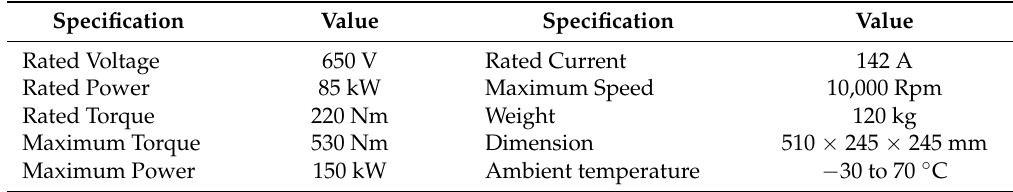
Figure 8. Power and torque characteristics of traction motor versus motor rpm. Table 6. Specifications of the electric machine [45].